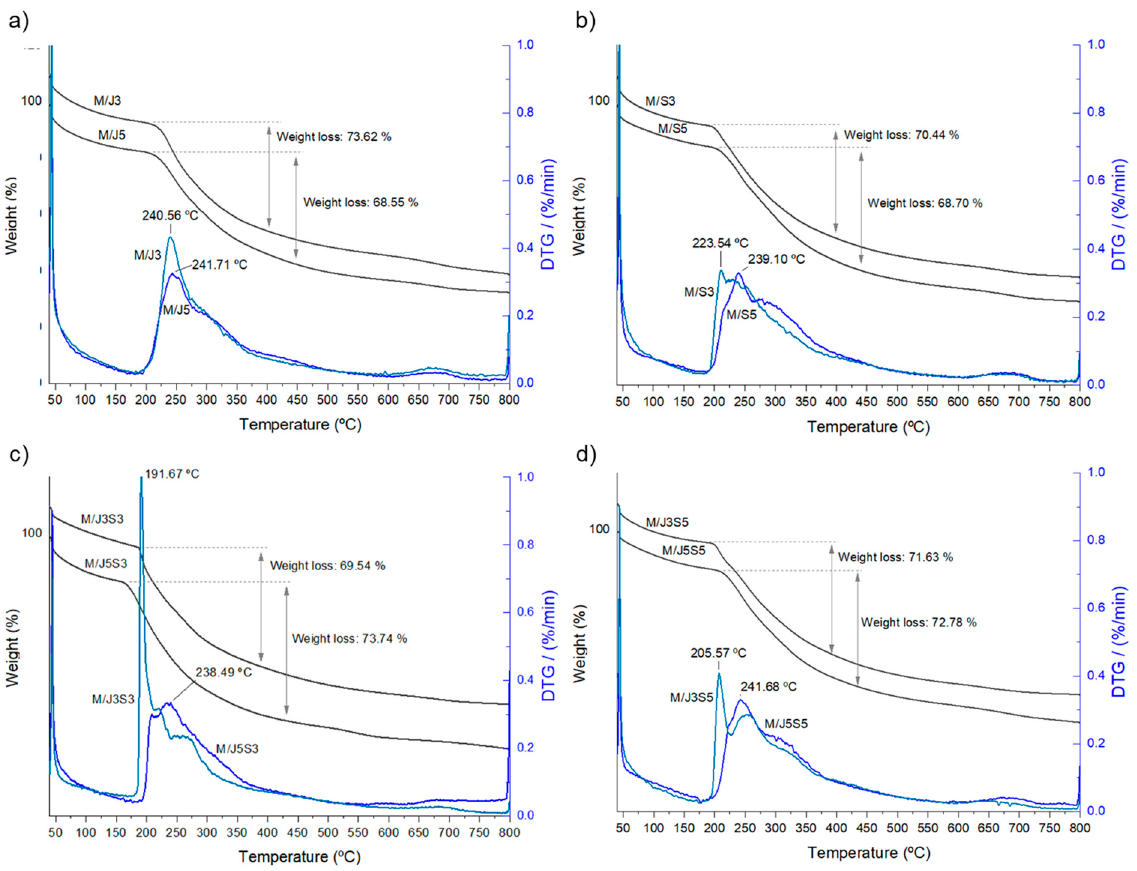
Figure 10. Thermogravimetric analysis (TGA) and derivative thermogravimetry (DTG—shown in blue) curves of the developed membranes in response to controlled heating from 40 to 800 °C: ( a ) M/J3 and M/J5; ( b ) M/S3 and M/S5; ( c ) M/J3S3 and M/J5S3; and ( d ) M/J3S5 and M/J5S5.